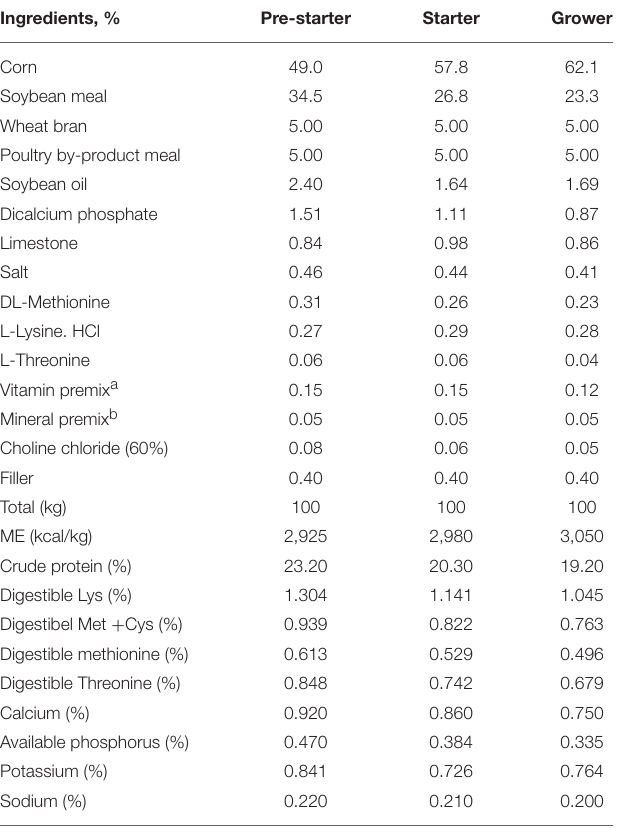
TABLE 2 | Specific monoclonal antibodies used in the flow cytometry analysis with their target cell